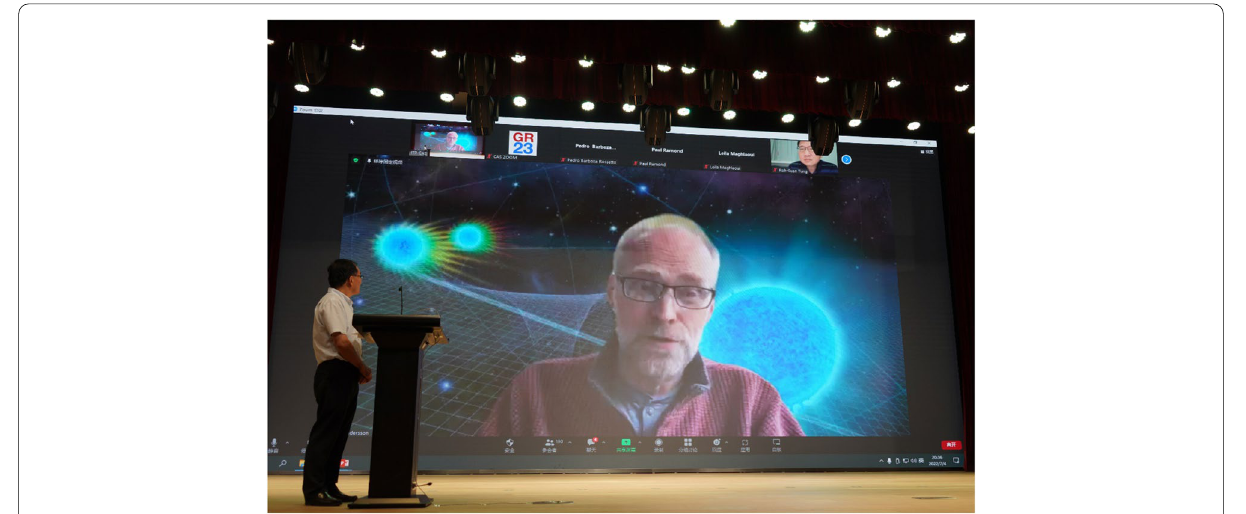
Fig. 1 Screenshot of the GR23 opening ceremony